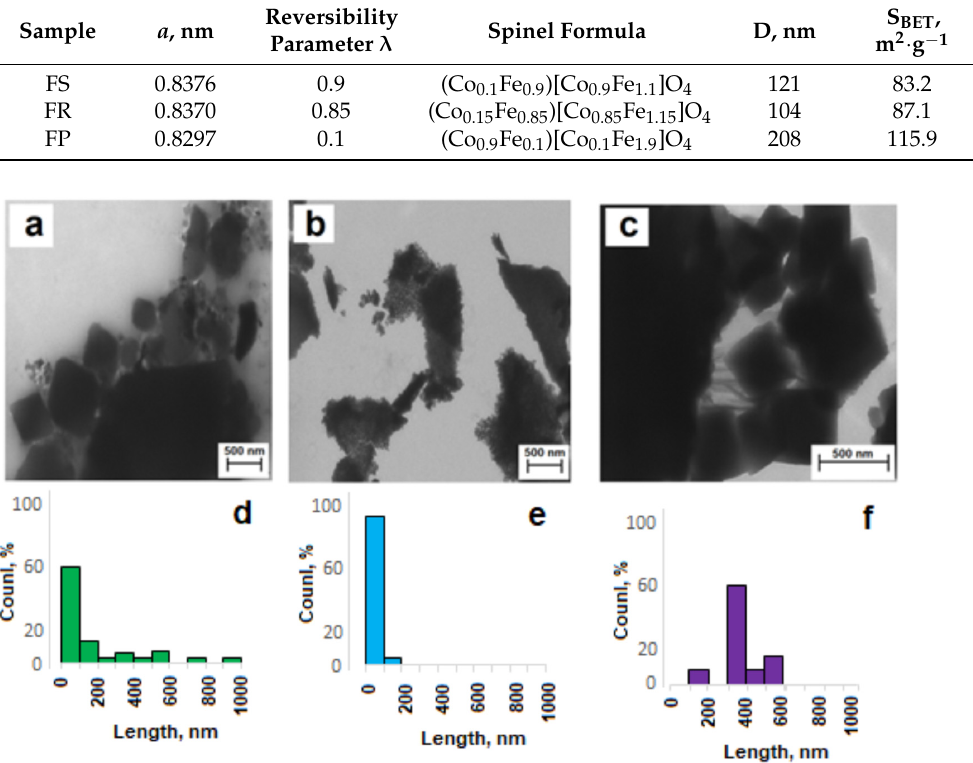
Figure 4. FTIR spectra for the synthesized composite materials ( a ) with detailing of the oscillation region for the oxide component ( b ). According to the results of thermographic analysis, for all samples there is a sharp change in mass in the region of 400–550 °C (Figure 5). In the same region, according to the